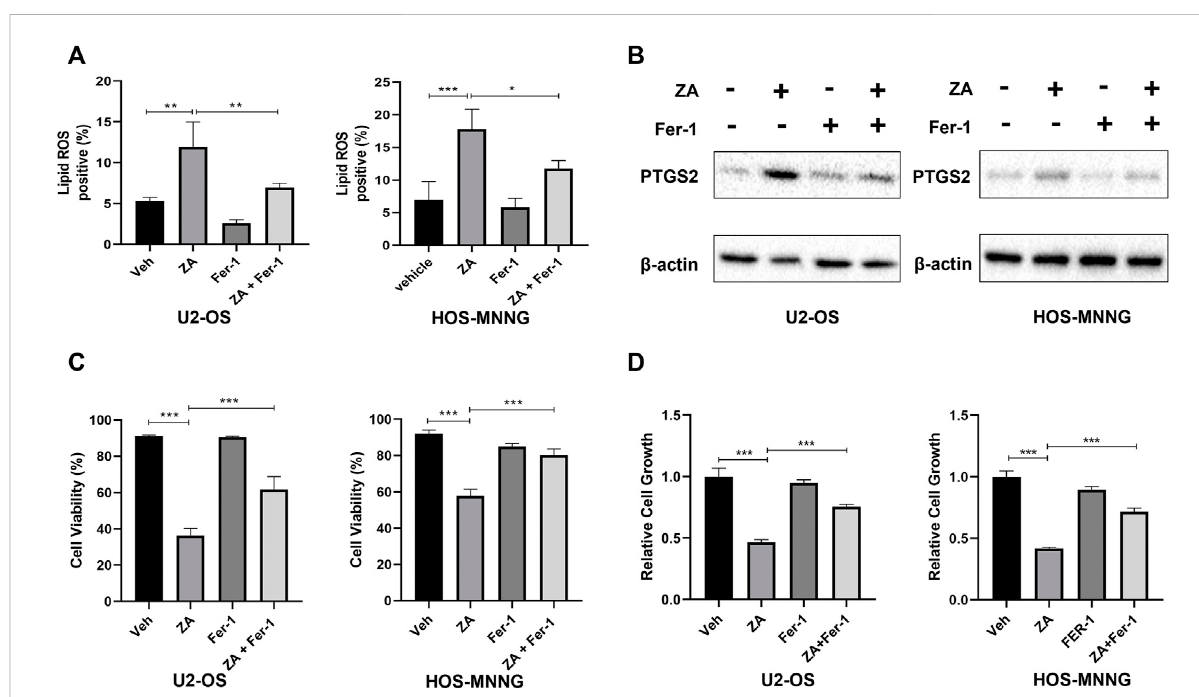
Zoledronicaciddecreasescellsurvivalofosteosarcomacellsthroughferroptosis. (A) Ferrostain-1reducesZA-enhancedlipidROSlevel.U2-OS and HOS-MNNG cells were treated with vehicle (Veh), ZA (20 μ M) and Ferrostatin-1 (Fer-1) (5 μ M) alone or together for 24 h. Lipid ROS were detectedby fl owcytometry. (B) Ferrostain-1reducesZA-enhancedPTGS2proteinlevel.CellsweretreatedwithZA(20 μ M)andFer-1(5 μ M)aloneor together respectively for 24 h and immunoblotted using PTGS2 antibody. (C,D) Ferrostain-1 prevents decreased cell survival induced ZA treatment. Cells were treated with ZA (20 μ M) and Fer-1 (5 μ M) either alone or together for 72 h, respectively. Viable and total cells were counted by trypan blue exclusion, respectively (C) . The percent of viable cells was calculated. In addition, viable cells were assayed using CCK8 reagent (D) .